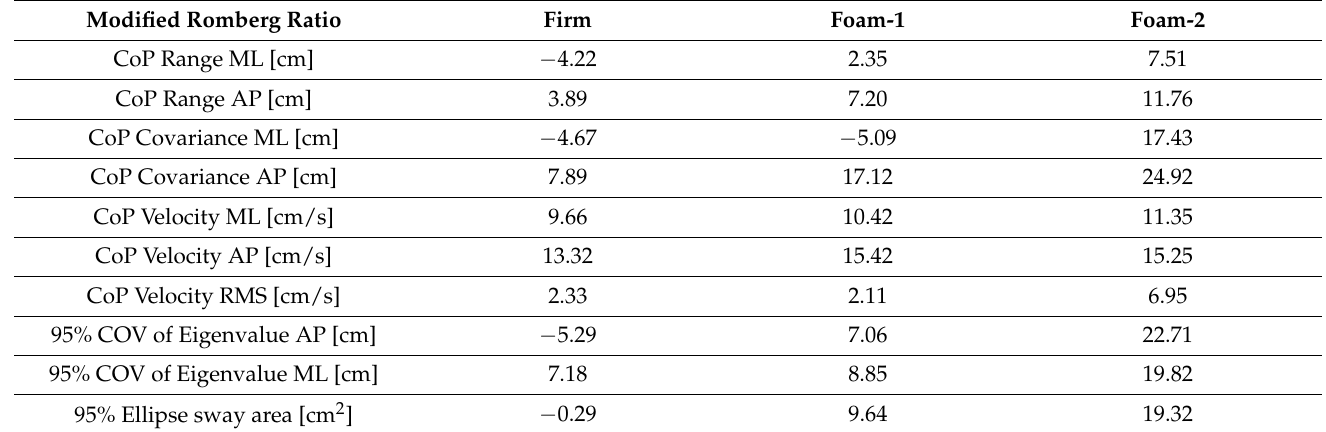
Table 4. Modified Romberg ratio for each surface condition.